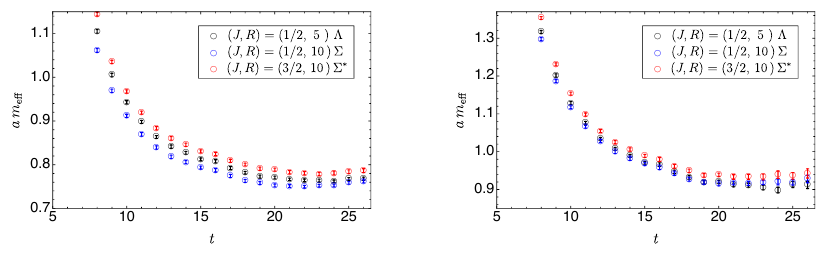
Figure 6. E ff ective mass plots for the lightest spin-1 / 2 and 3 / 2 chimera baryons in partially quenched approximation. The details of the ensemble can be found in Ref. [10]. The valence fermions masses are ( am f v , am as ) = ( − 0 . 71 , − 1 . 01) and ( − 0 . 75 , − 0 . 8) for the left and right panels, v